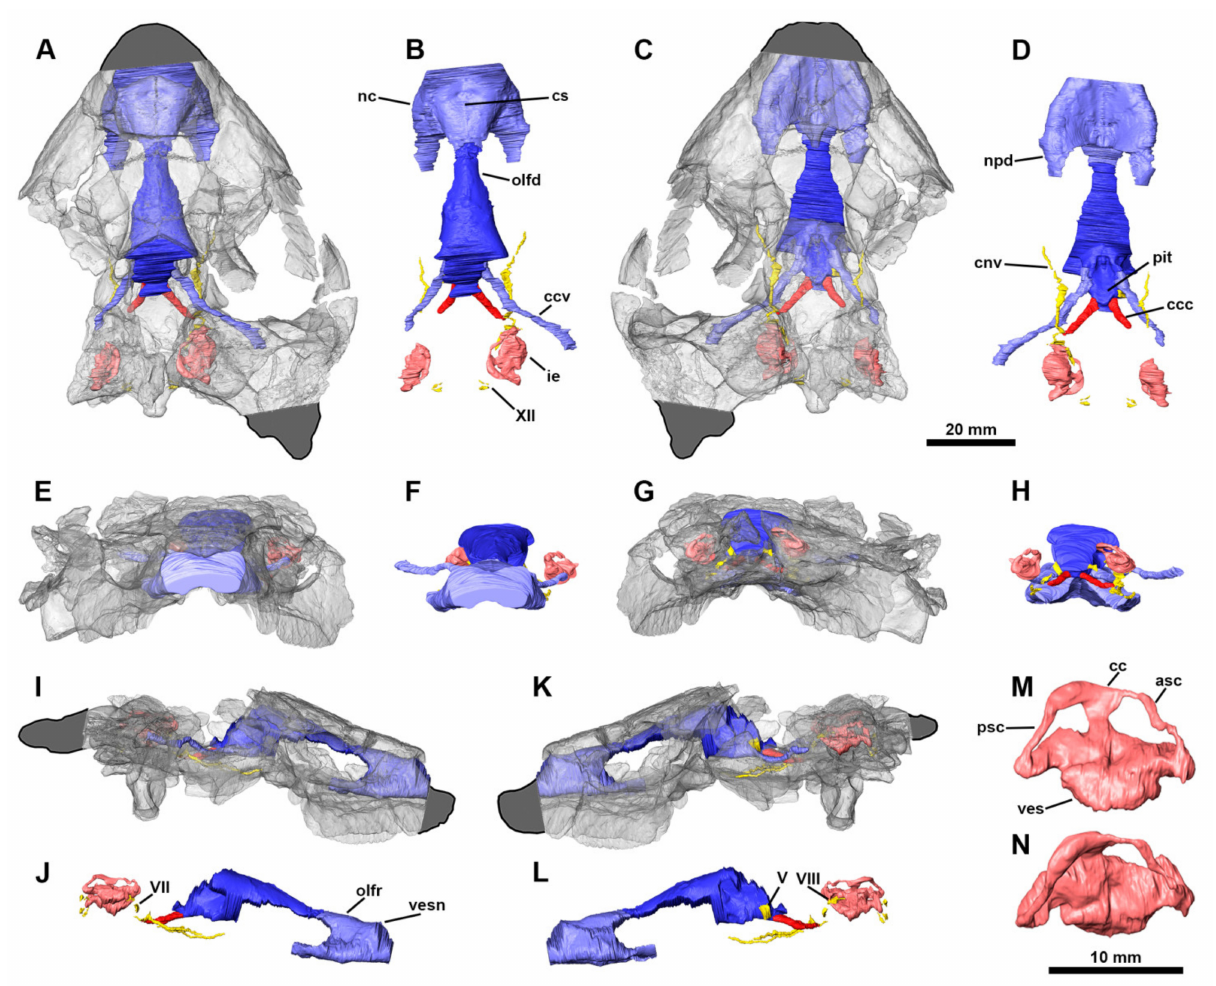
Figure 4. Osteological and neuroanatomical three-dimensional virtual reconstructions of the specimen MNHN.F.SPP33, corresponding to the holotype of Tartaruscola teodorii (Bothremydidae, Foxemydina), from the lower Ypresian (early Eocene) of Saint-Papoul (Aude, France). The osseous elements (in grey) have been visualized as transparent ( A , C , E , G , I , K ) in order to show the reconstruction of the endocast of cranial and nasal cavities (in blue) ( B , D , F , H , J , L ). The reconstructions are presented in dorsal ( A , B ), ventral ( C , D ), anterior ( E , F ), posterior ( G , H ), right lateral ( I , J ), and left lateral ( K , L ) views. ( M , N ), Right inner ear reconstruction in lateral ( M ) and dorsal ( N ) views. Abbreviations: asc, anterior semicircular canal; cc, crus communis; ccc, canalis caroticus cerebralis; ccv, canalis cavernosus; cnv, canalis nervi vidiani; cs, cartilaginous septum; ie, inner ear; nc, nasal cavities; npd, nasopharyngeal duct; olfd, olfactory duct; olfr, olfactory region; pit, pituitary fossa; psc, posterior semicircular canal; V, trigeminal nerve; ves, vestibulum; vesn, vestibulum nasi; VII, facial nerve; VIII, vestibulocochlear nerve; XII, hypoglossal